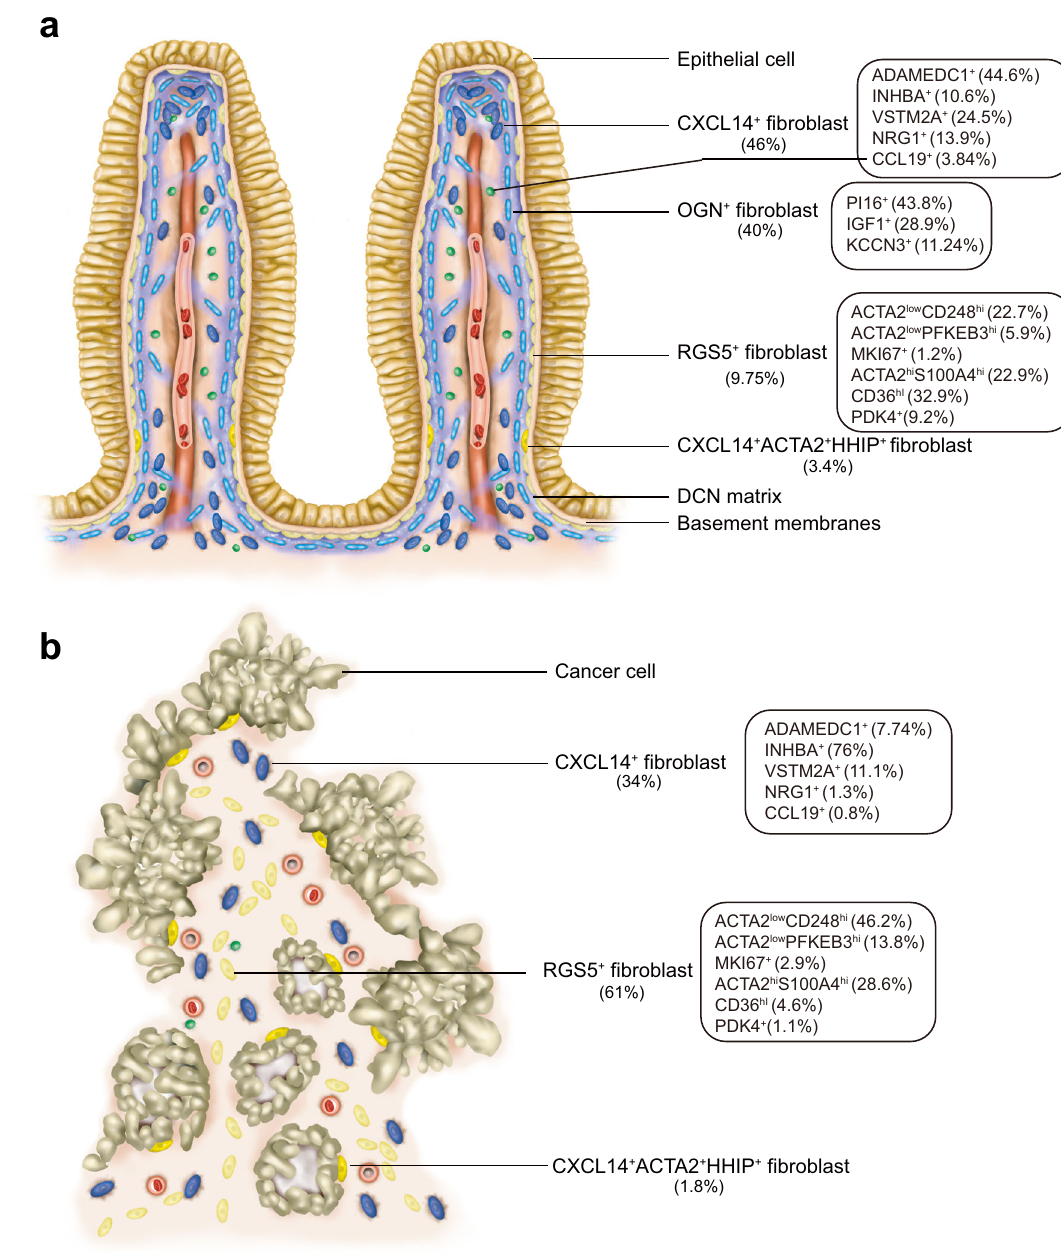
Fig. 7 Fibroblastic populations in human colon mucosa and colon cancer tissues. Schematic illustration of the composition and location of types of fi broblasts in a normal human colon mucosa and b colon cancer tissues. The cell composition ratio of the subpopulation is indicated in the rectangular box. The rest of the cell types are omitted in the schematic